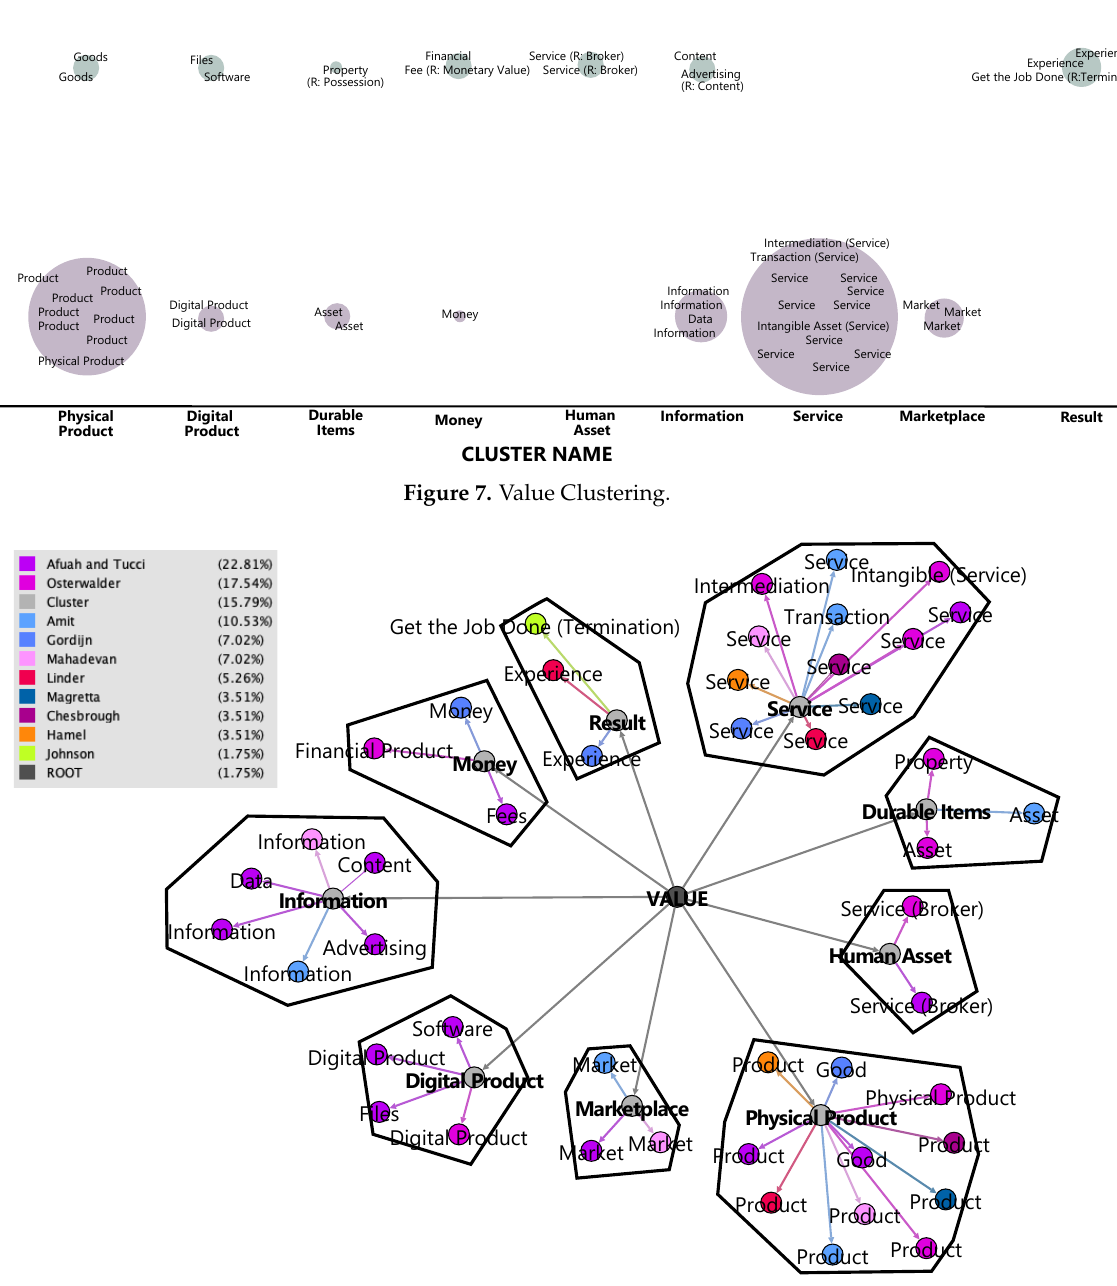
Figure 7. Value Clustering.